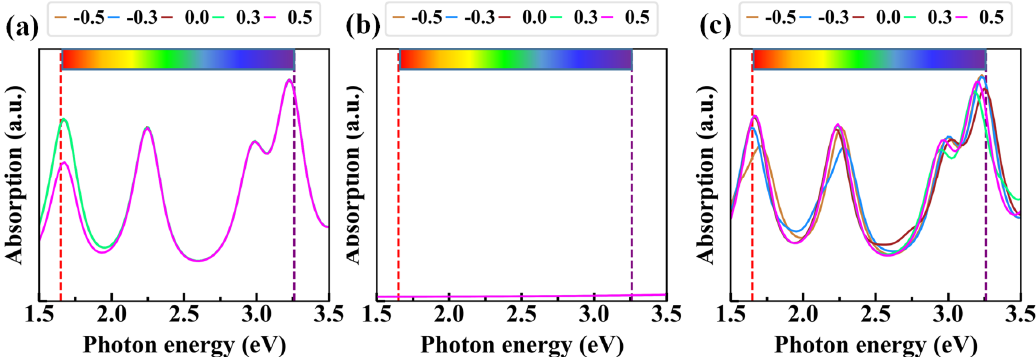
Figure 6. The absorption of ( a ) graphene, ( b ) AlN, and ( c ) the graphene/AlN heterojunction under a di ff erent external electric different external electric field.